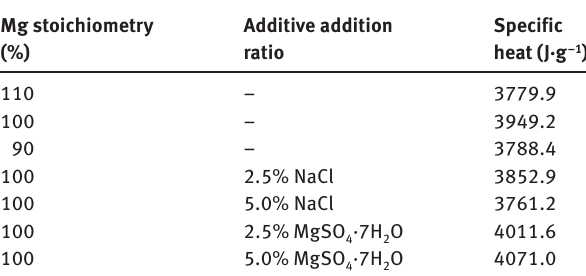
Table 1: The change of specific heat values of the reactions with Mg stoichiometry, NaCl and MgSO 4 ·7H 2 O addition (calculated by using FactSage